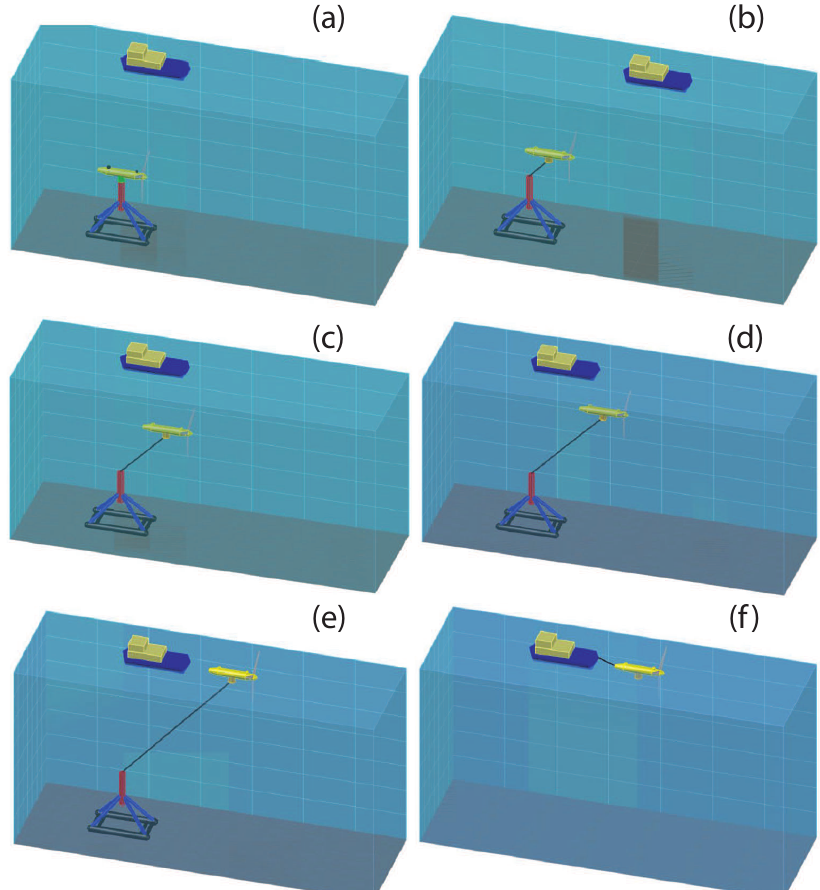
Figure 10. Automated maintenance maneuver of the gondola (emersion sequence): ( a ) the water begins to be emptied out of the gondola; ( b ) separation between the TEC structure and the gondola and start of emersion process; ( c ) emersion maneuver in closed loop; ( d ) emersion maneuver in closed loop (cont.); ( e ) emersion maneuver finalized, the inner ballasts are completely empty and are disconnected from the control system; and ( f ) start of maintenance